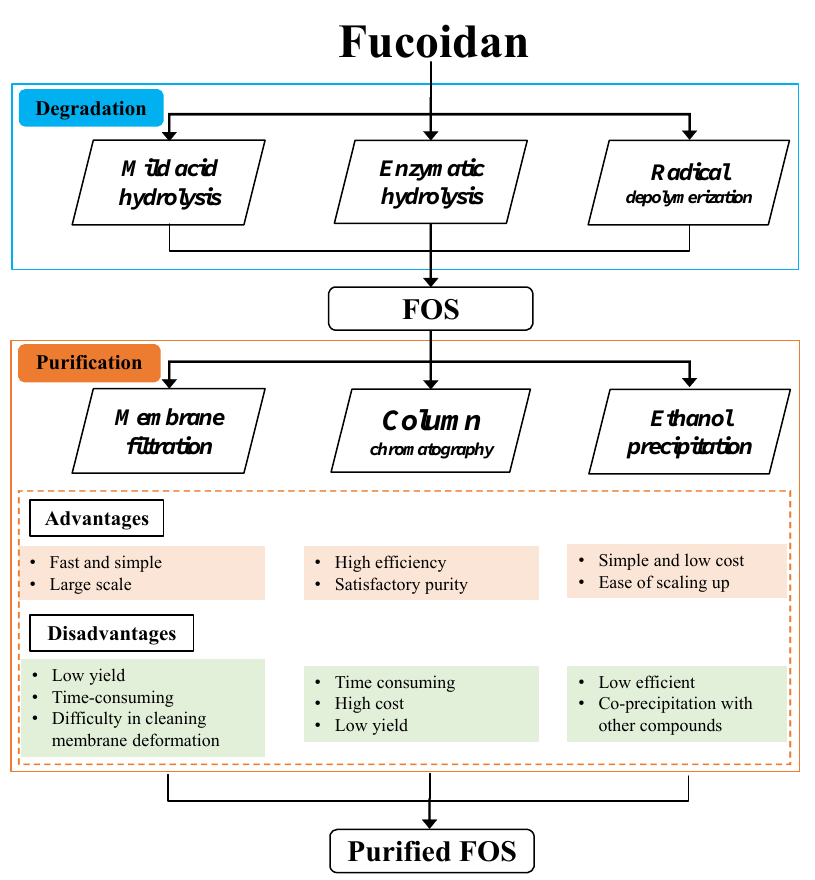
Figure 3. Schematic diagram of FOS degradation and purification processes.